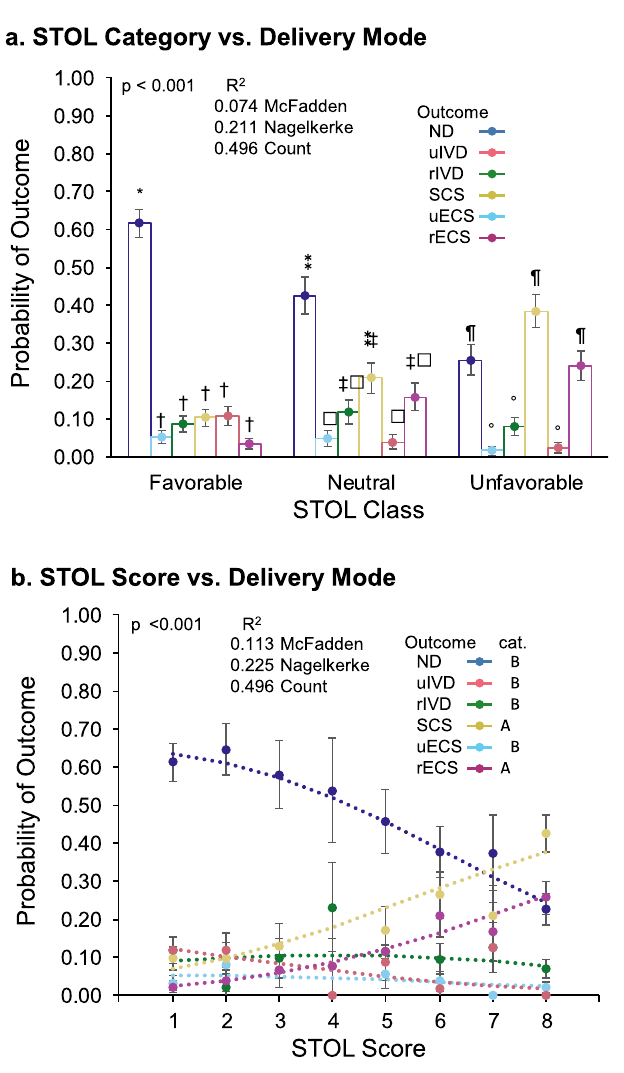
Figure 1. STOL models versus delivery modes. We modeled the STOL categories (favorable, neutral, unfavorable) and the STOL scores against various birth outcomes using multinomial logistic models. R 2 values are adjusted McFadden pseudo-R 2 values. ( a ) STOL categories vs. delivery modes. Columns represent probabilities of each outcome vs. indicated STOL category. Error bars are standard errors calculated for ratios/ probabilities. The symbols above each column indicate significant differences among the probabilities within each category (marginal means). Two outcomes that share a symbol do not differ significantly within that category. Specifically: favorable has 2 groups (*, †); neutral has 3 overlapping groups ( ⁑ , ‡, δ); and unfavorable has 2 groups (¶, °). Comparisons were not performed between categories. CS Cesarean Section, r * related to cephalopelvic disproportion, u * unrelated to cephalopelvic disproportion, STOL simulated trial of labor. ( b ) STOL scores versus delivery mode probabilities. Lines represent predicted probabilities of outcomes, treating STOL as a continuous variable. Models of logistic, linear predictor slopes were compared by bootstraps of pairwise differences. The probabilities of scheduled CS and emergency CS procedures related to cephalopelvic disproportion (labeled a ) increased significantly with increasing STOL scores compared with all other outcomes (labeled b ). Slopes were transformed from the model (logit) to the response scale (probability) for the figure. Points are measured as outcome probabilities, and error bars are standard errors for ratios/probabilities. CS cesarean section, r* related to cephalopelvic disproportion, u* unrelated to cephalopelvic disproportion, STOL simulated trial of